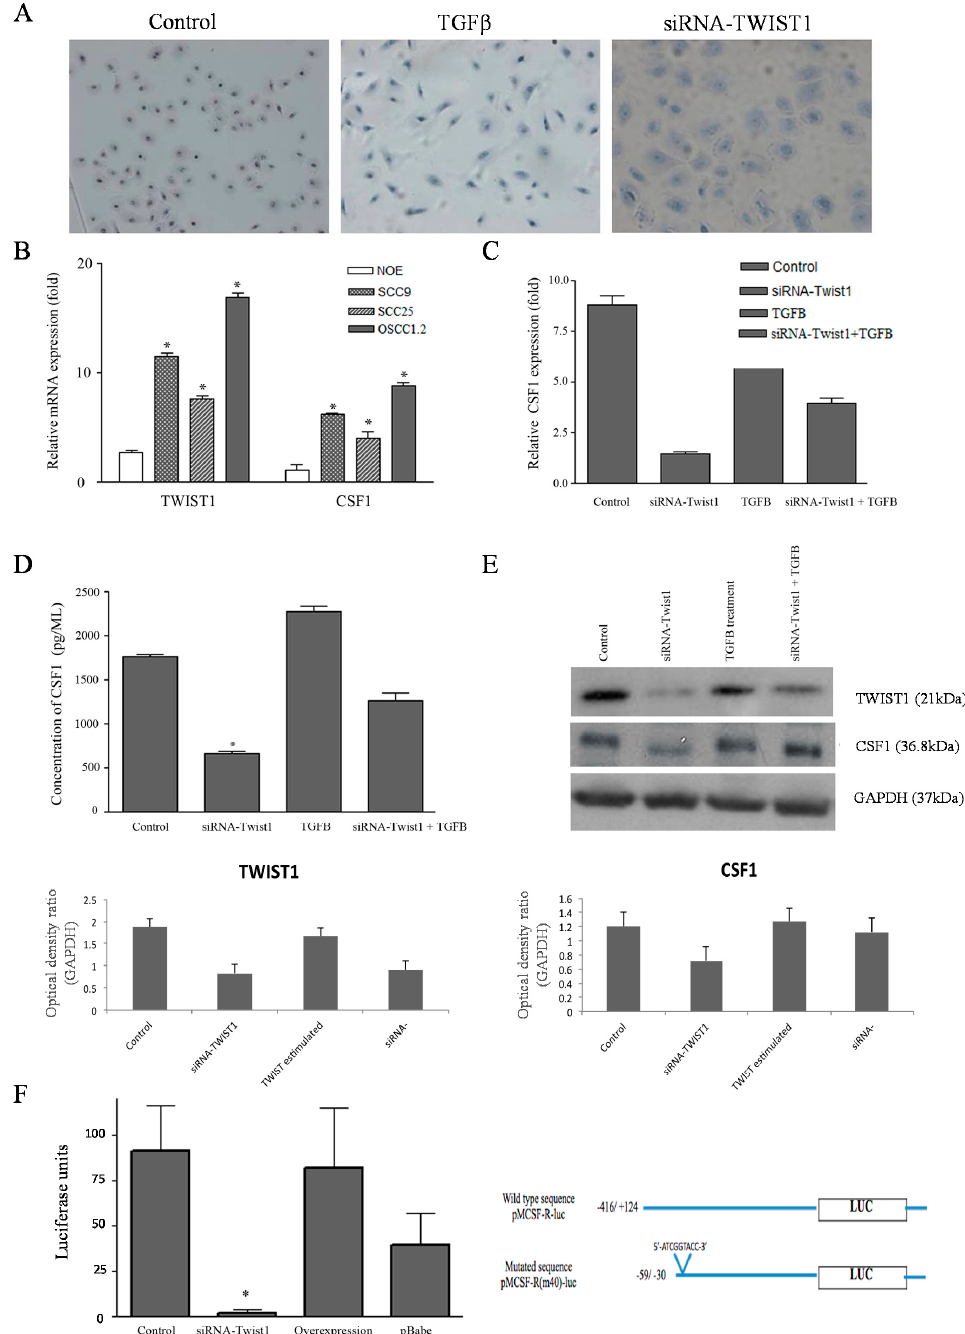
Figure 3. TWIST1 can regulate CSF1 expression in oral cancer. ( A ) Morphological aspects of oral normal epithelial cell lines (NOE) after stimulation with TGF β showing mesenchymal phenotype. The same cells after knockdown TWIST1 but under stimulation of TGF β show mixed aspects of epithelial and mesenchymal phenotype. ( B ) Transcript levels of TWIST1 and CSF1 estimated by qRT-PCR was increased in a highly metastatic oral cancer cell line (OSCC1.2/RBT3), as well as in the invasive SCC9 cells in comparison to the less-invasive OSCC cell line (SCC25) and normal oral epithelial (NOE) cells. GAPDH was used to normalize the gene expression data. Y-axis corresponds to the relative quantification of the mRNA levels and X-axis represents the genes. ( C ) Significant downregulation of CSF1 was achieved after TWIST1 gene silencing. GAPDH was used as an internal control. Y-axis corresponds to the relative quantification of transcript levels; X-axis represents control OSCC cells, cells expressing siRNA and cells knockdown TWIST1 and treated with TGF β . ( D ) Concentration of GMCSF (pg/mL; 2 × 10 5 cells) measured by ELISA (enzyme-linked immunosorbent assay) in supernatants from OSCC cell culture. Data are represented as mean ± SD (standard deviation) from four separate experiments. Cells downexpressing